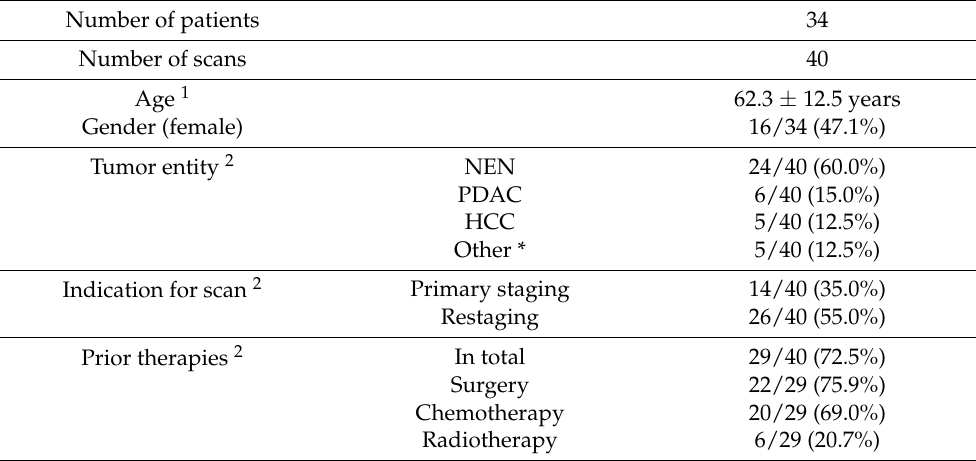
Table 1. Patient characteristics.